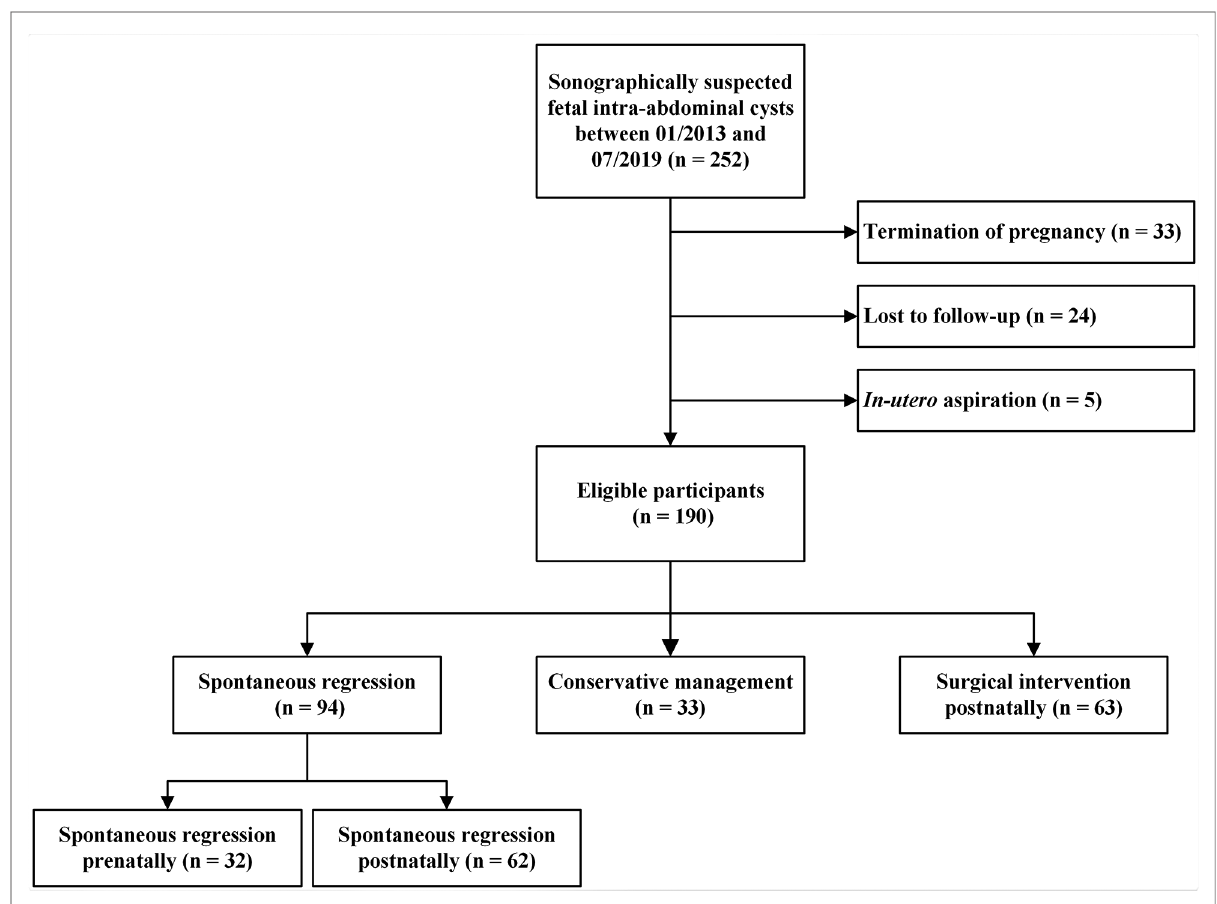
FIGURE 1 A trial fl owchart summarizing fetal outcomes in the prenatal and postpartum